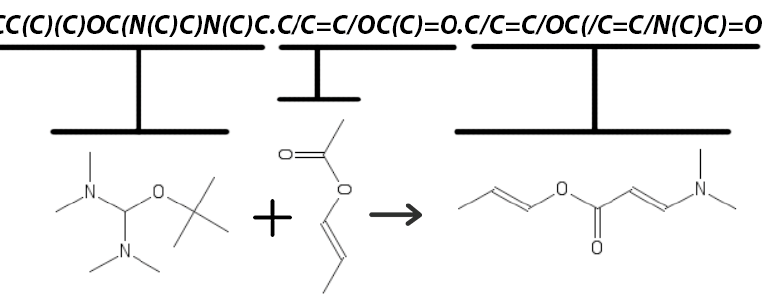
Figure 1. A graphical representation of the reaction and its notation in SMILES. This relation maps SMILES encoding segments into corresponding molecules.